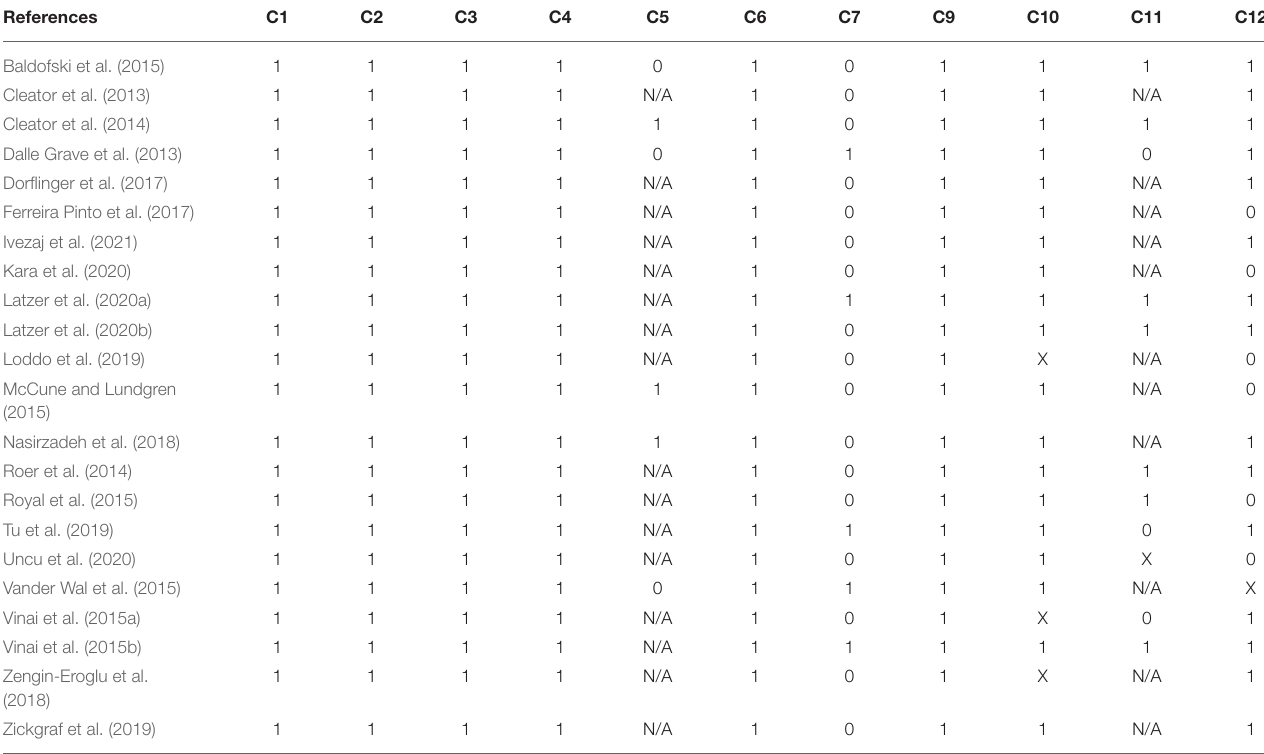
TABLE 3 | Quality appraisal of the 22 selected studies using the 11 criteria adapted from Rozenblat et al.